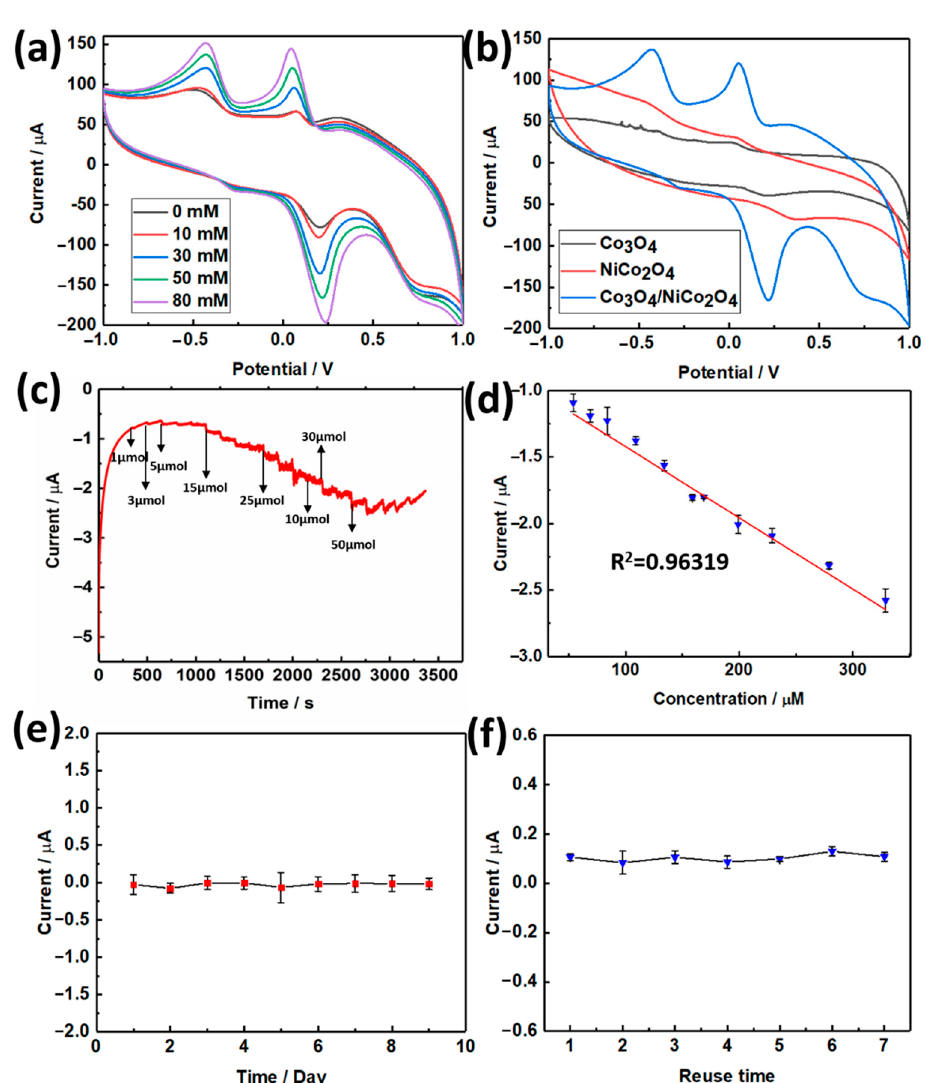
Figure 5. ( a ) The CVs curve of the Co 3 O 4 /NiCo 2 O 4 electrochemical biosensor, detecting dopamine with different concentrations at a scanning rate of 50 mV/s. ( b ) The CVs curve of Co 3 O 4 , NiCo 2 O 4 , Co 3 O 4 /NiCo 2 O 4 at a scanning rate of 50 mV/s, with the addition of 50 µM of dopamine. ( c ) The I-t curve of the Co 3 O 4 /NiCo 2 O 4 electrochemical biosensor, adding different concentrations of dopamine. ( d ) The linear regression curve, drawn based on Figure 3c. ( e ) The long time service life test of the dopamine electrochemical biosensor. ( f ) Th reuse times test of the dopamine electrochemical biosensor.